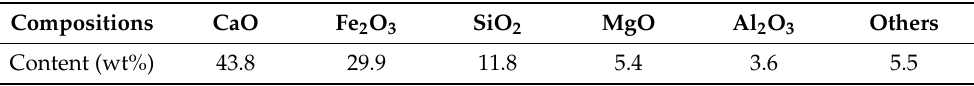
Table 3. Chemical compositions of slag used for testing.